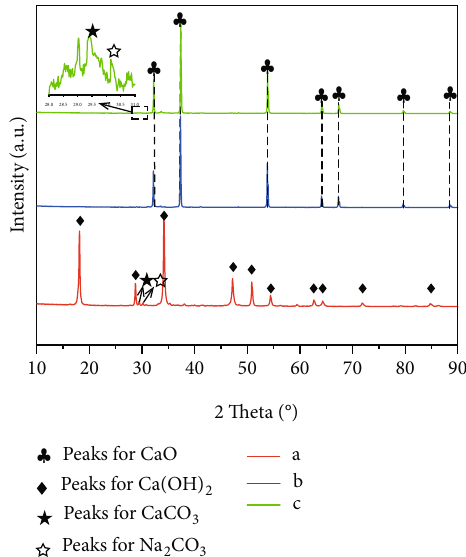
Figure 5: FTIR spectra of the (a) CS-800 and (b) 15wt.% Na CS-800.